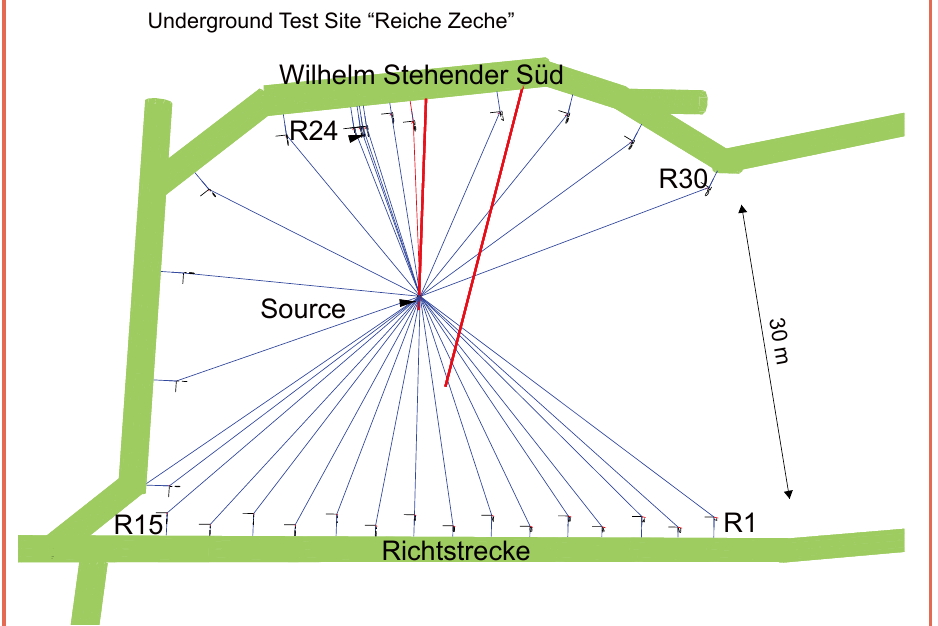
Figure 3. The test site of the GFZ at the education and research mine “Reiche Zeche” in plain view with the three surrounding galleries (green), the boreholes (red), and the geophone anchors (R1-R30, black). The lower horizontal gallery is named Richtstrecke; the upper gallery is called Wilhelm Stehender